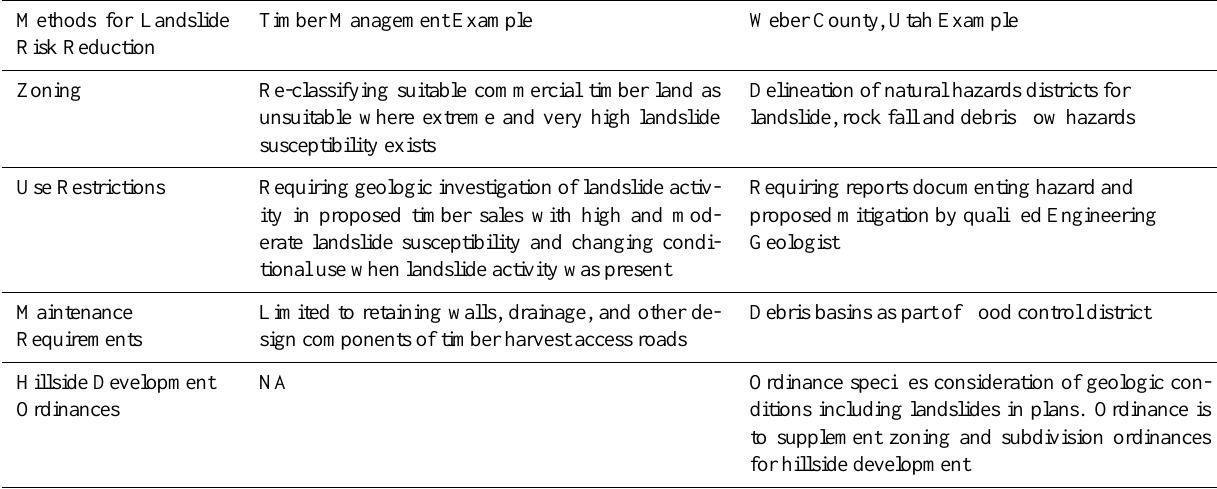
Table 1. Comparison of common land planning actions for reducing landslide hazard as implemented in a rural and urban setting. Methods for